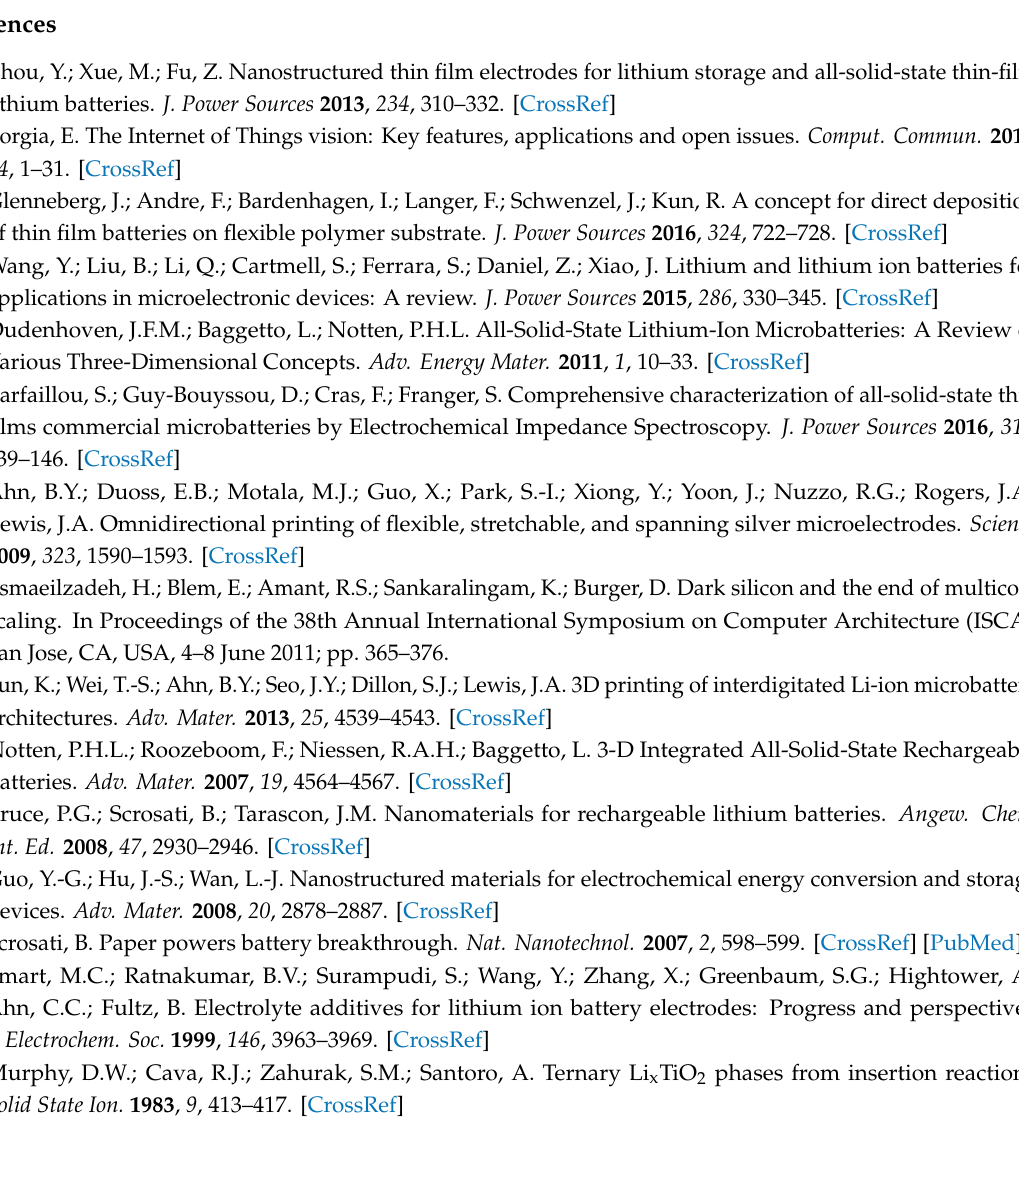
Figure S1: Images of LTO thin-films on (a) quartz, (b) gold-coated quartz and (c) silicon as